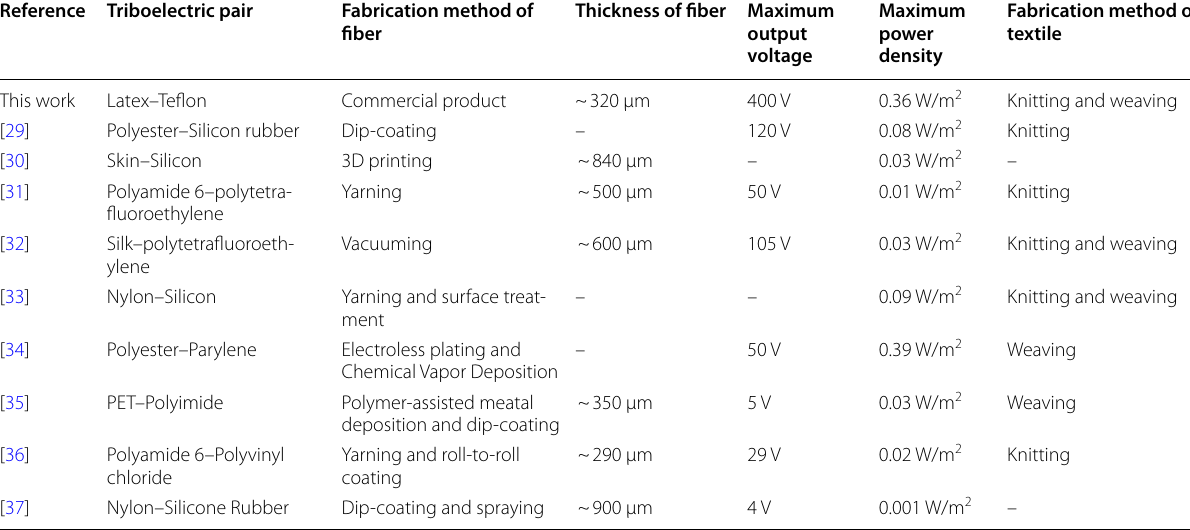
Table 1 Comparison of the performance of different fiber type T‑TENG Reference Triboelectric